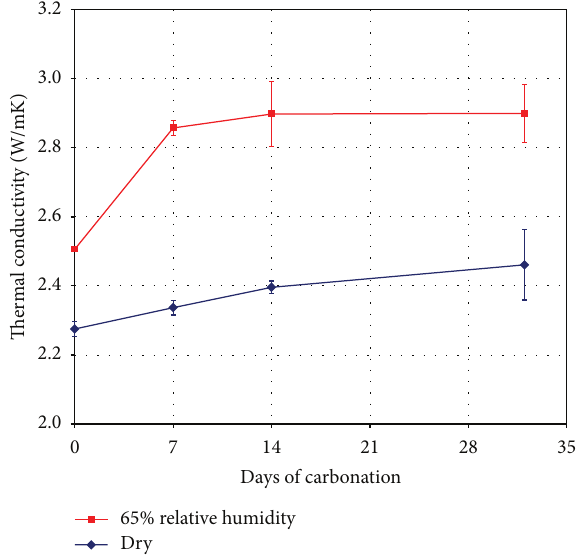
Figure 11: The thermal conductivity during carbonation measured at 65% relative humidity and at dry